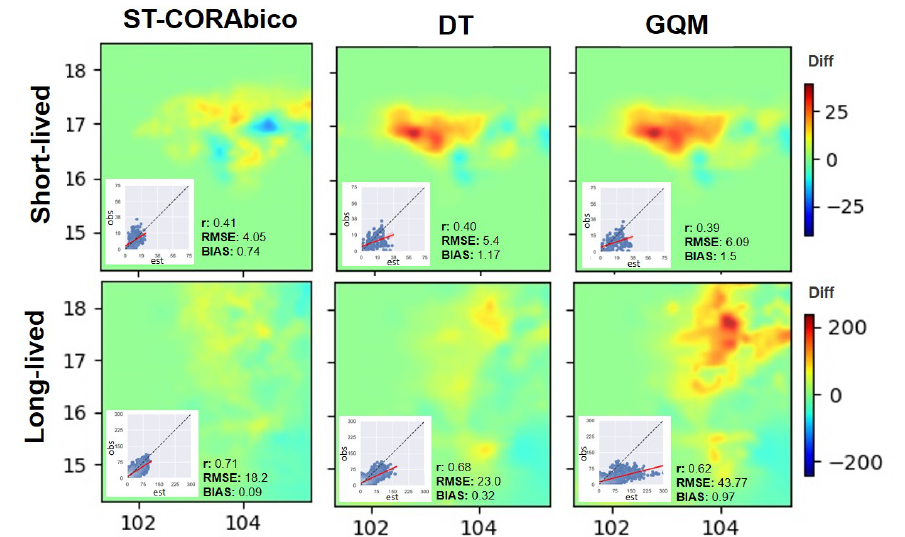
Figure 9. Comparison between ST-CORAbico vs Distribution Transformation (DT) and Gamma Quantile Mapping